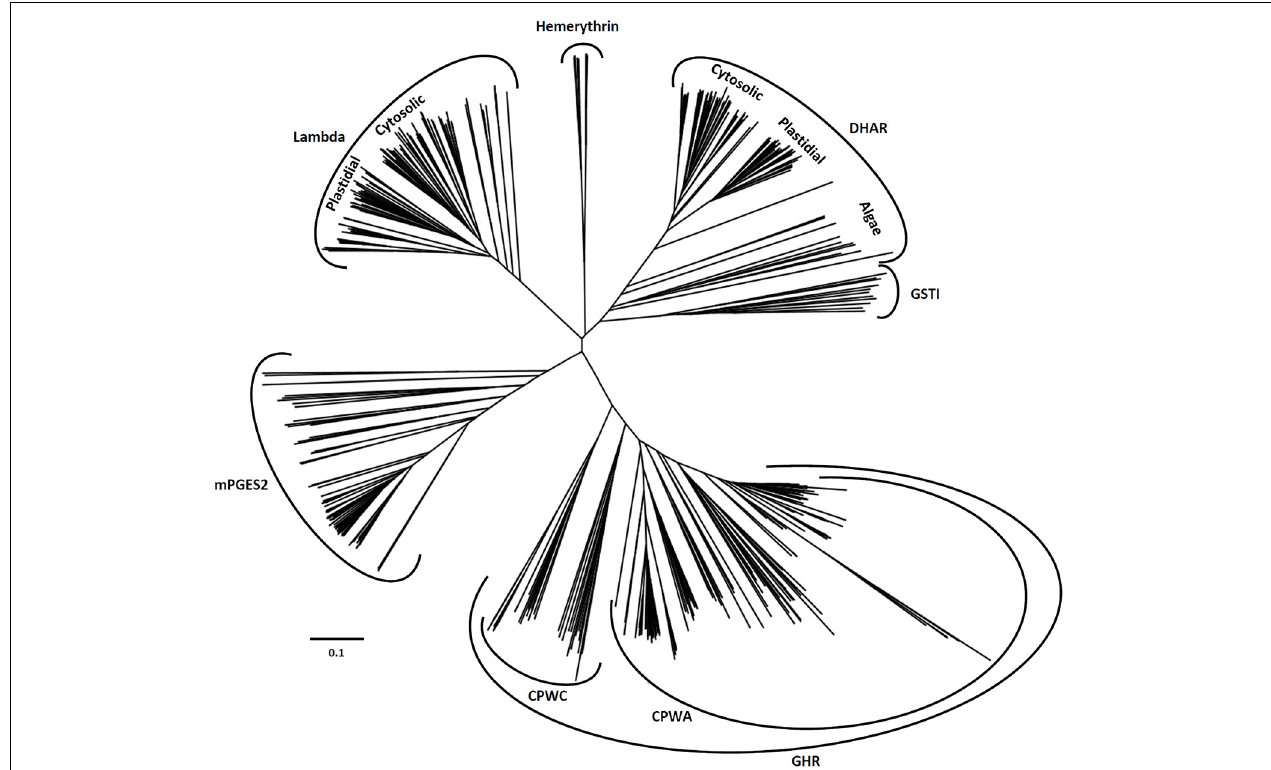
FIGURE 2 | Unrooted phylogenetic tree of Cys-GSTs present in the green lineage. Sequences were aligned with PROMALS3D using 1Z9H, 3PPU, and 4PQH PDB structures as templates. Then the alignment has been manually adjusted with Seaview software. The phylogenetic tree was constructed with BioNJ and edited with Figtree software (http://tree